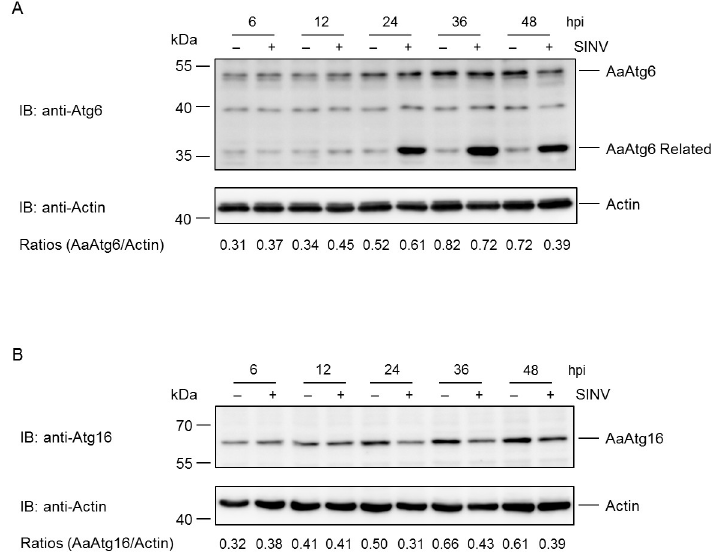
Fig 7. Protein level of AaAtg6 and AaAtg16 at different time points post SINV infection. C6/36 cells were infected with SINV at MOI of 5. (A) and (B) The protein level of AaAtg6 and AaAtg16 at different time points post infection were analysed by Western Blotting, respectively. The relative level of AaAtg6 and AaAtg16 to that of actin was quantified by ImageJ according to materials and methods.